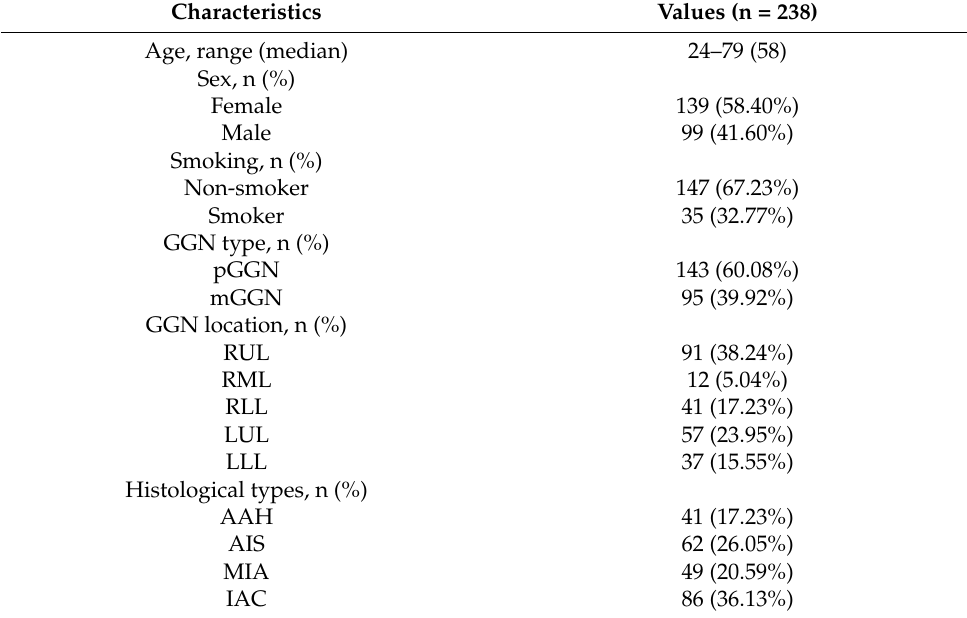
Table 1. Clinical information and histologic results of the patients.